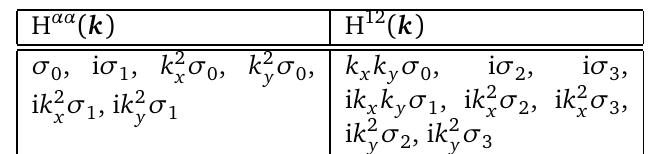
Table 4: Terms that can appear for four-band k · p Hamiltonian